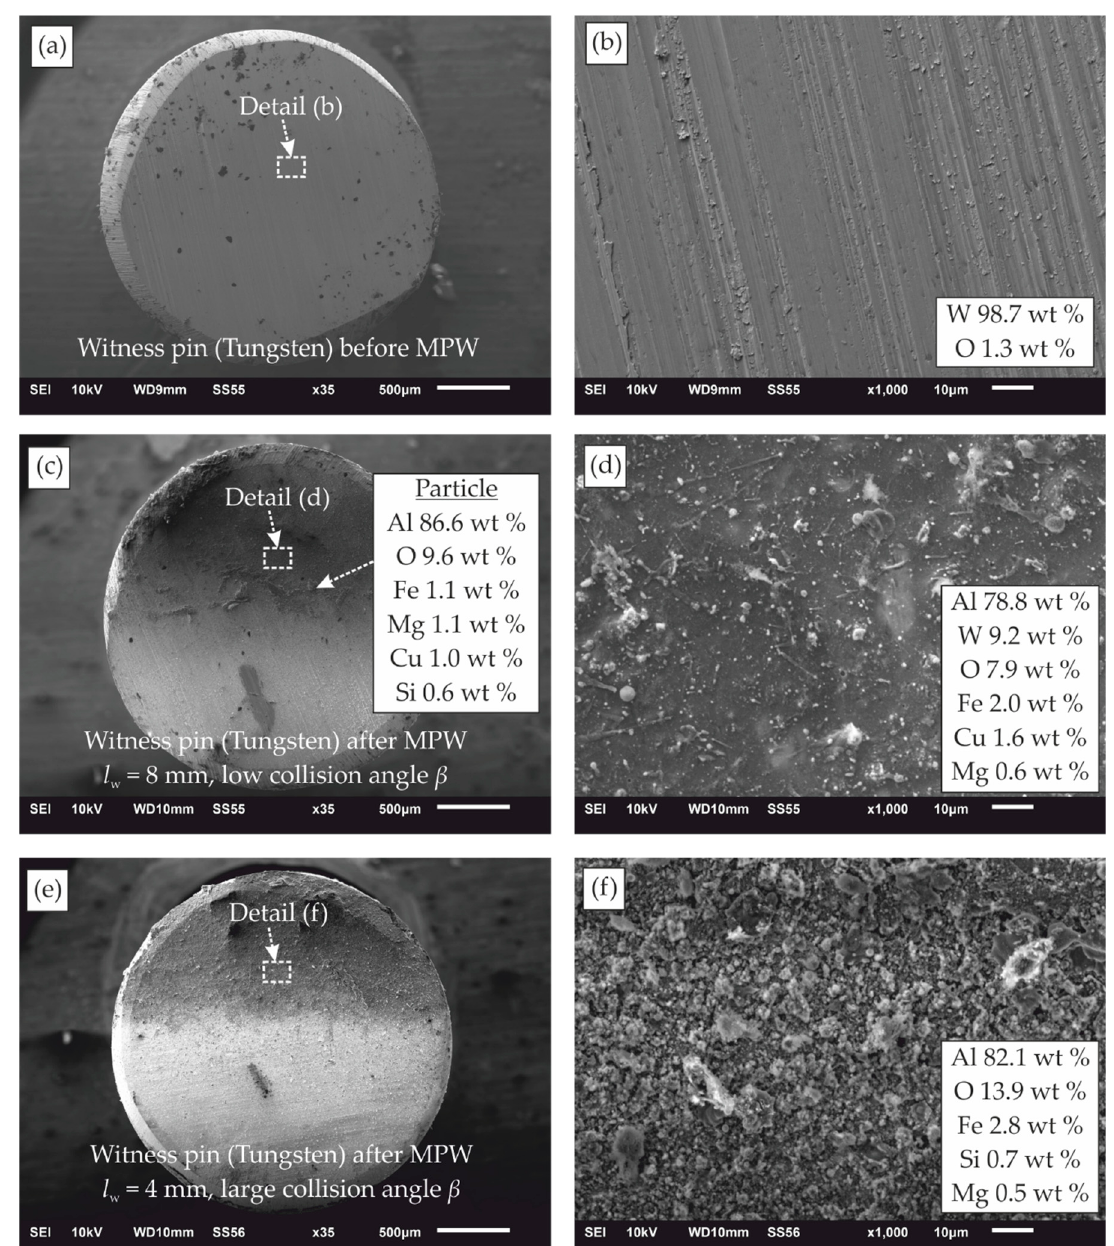
Figure 13. Surface topography and chemical composition of the tungsten witness pins ( a , b ) before MPW and after MPW with ( c , d ) low collision angle and ( e , f ) large collision angle.